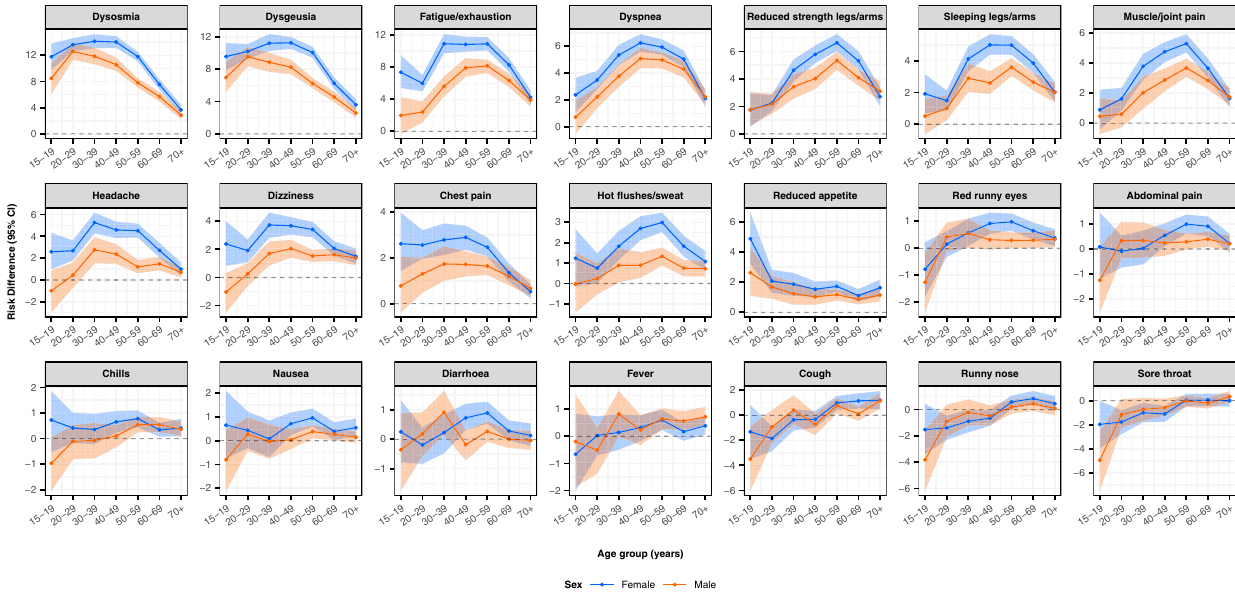
Fig. 4 Risk differences of symptoms after 6-12 months, comparing SARS-CoV-2 test-positive and test-negative participants, strati fi ed by sex and age group. Note: Risk differences (center) with 95% con fi dence intervals (width of error bands) were adjusted for comorbidities, obesity, healthcare occupation, and time after testing (in